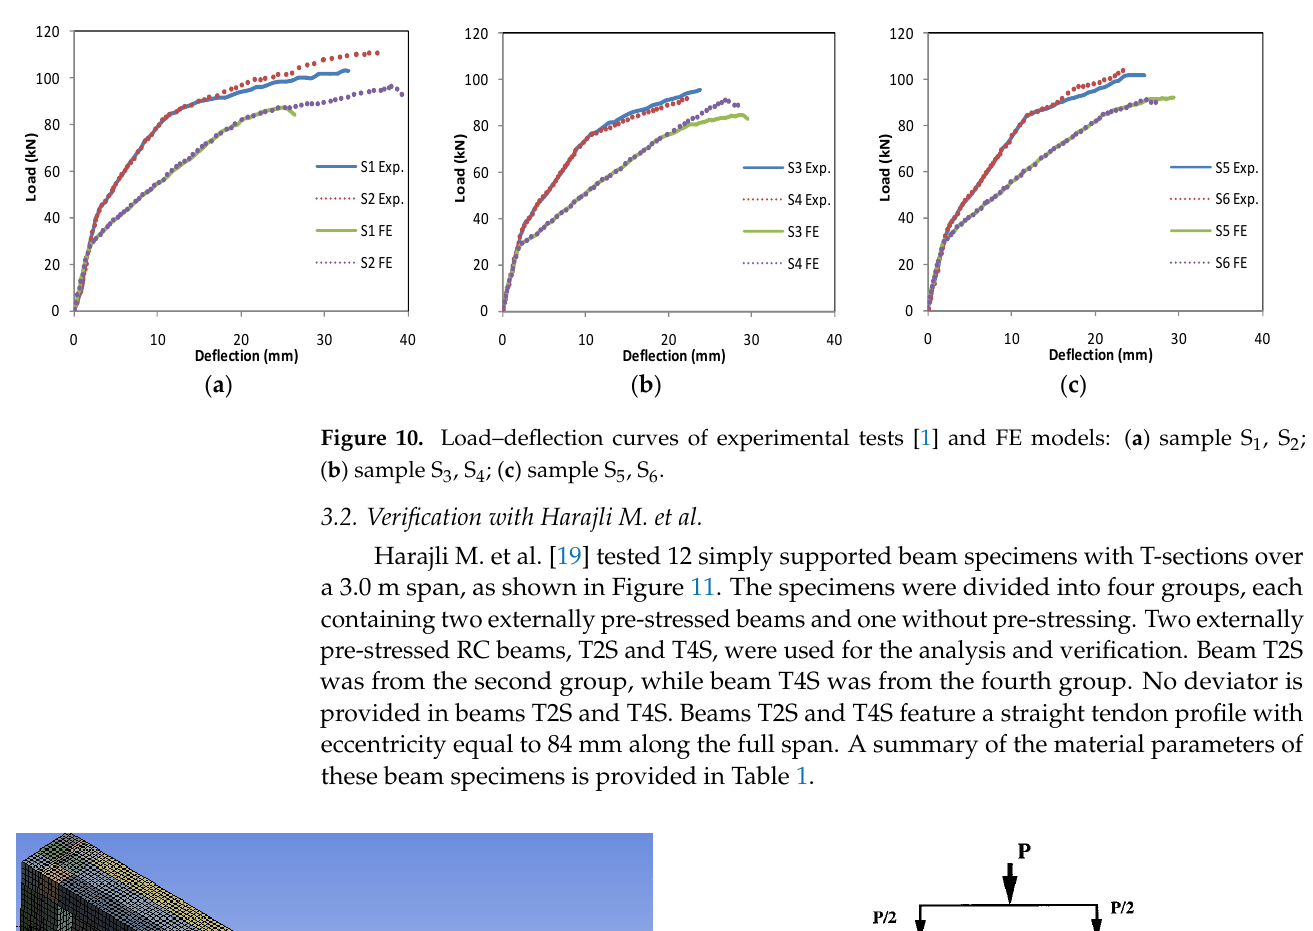
8 of 16 Figure 9. Deflection of sample S 0 at failure.